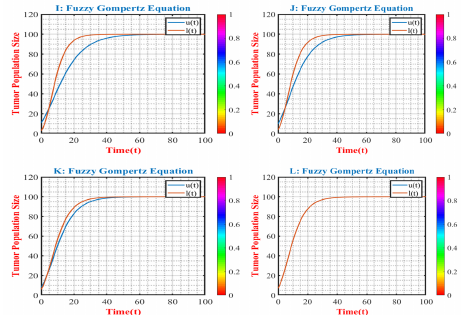
Figure 3. In this case, the system of Gompertz equation with only the initial condition as fuzzy is defined and the tumor population size as a function of time for α = 0, α = 0 . 25, α = 0 . 75 and α = 1 are illustrated.